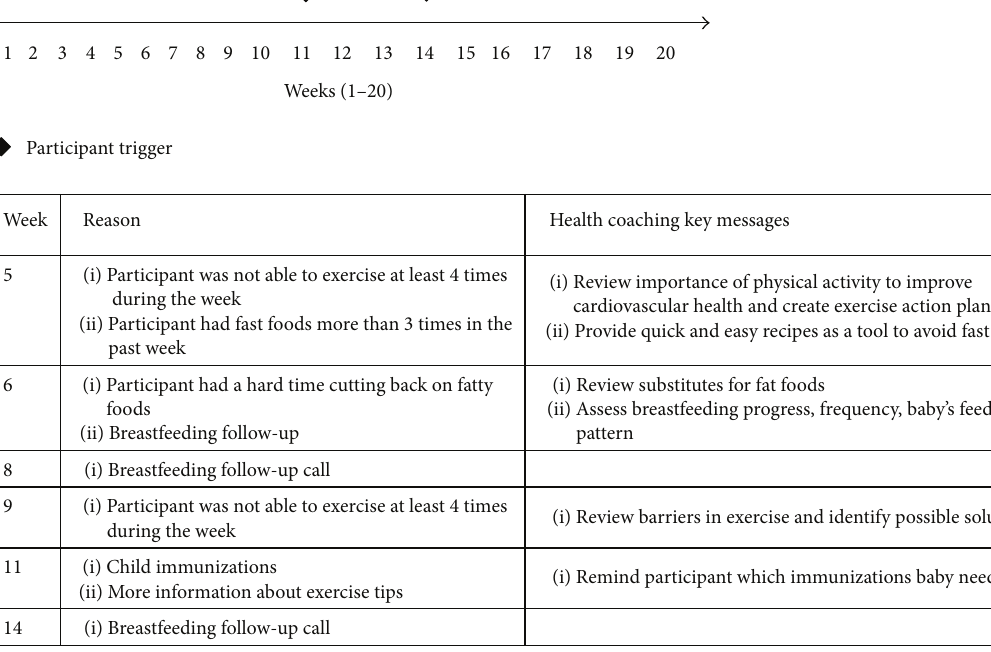
Figure 3: HIT enabled phone call system, participant triggers, and context-based health coaching messages: summary for Ms. C. at San Francisco WIC. Timeline of calls and weekly triggers indicated by Ms. C. The timeline displays the weekly phone calls to Ms. C., from weeks 1 through 20 by the ATSM system. The diamonds indicate triggers and actionable events, and the table summarizes the reason for triggers each week. A health coach monitors the daily and weekly reports from the HIT system to follow-up with the participants through a trigger based